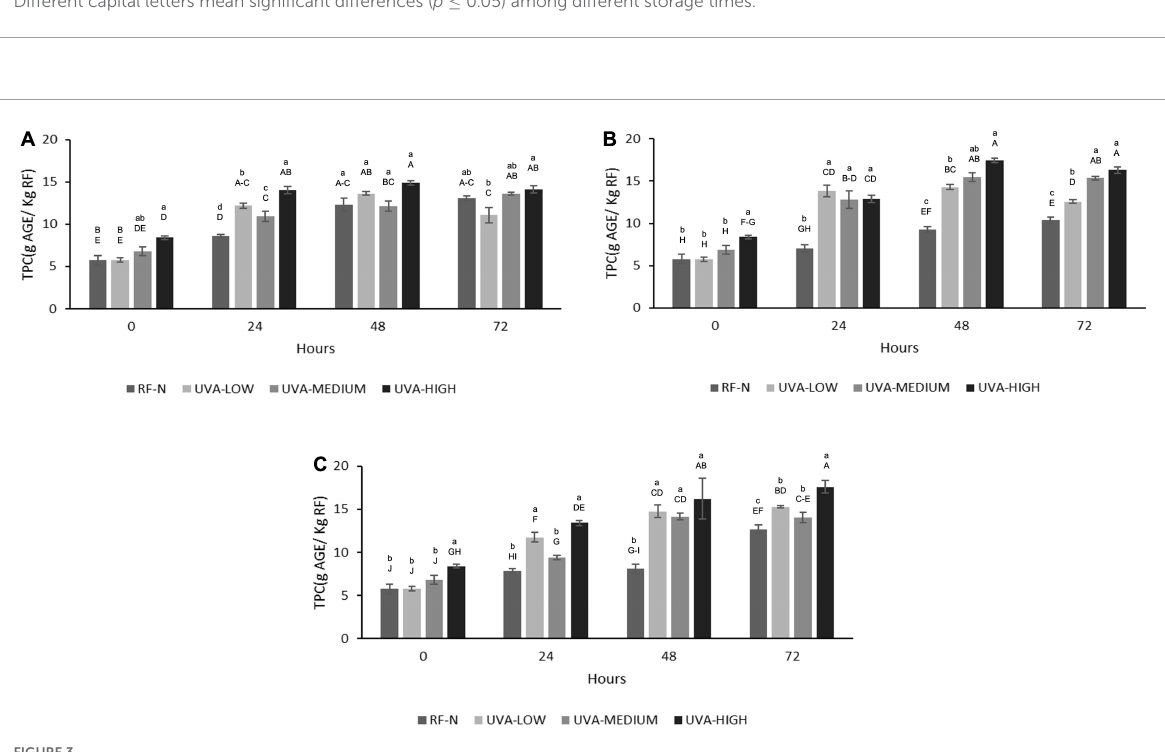
FIGURE3 Total phenolic content (TPC) of UVA-treated strawberry by-products during storage at (A) 5 ◦ C, (B) 10 ◦ C, (C) 15 ◦ C. RF-N: Strawberry agro-industrial by-product control. UVA-LOW: RF irradiated with 28.8 KJ/m 2 . UVA-MEDIUM: RF irradiated with 57.6 KJ/m 2 . UVA-HIGH: RF irradiated with 86.4 KJ/m 2 . Different lower-case letter, means significant differences ( p ≤ 0.05) between the different treatments at the same storage time. Different capital letter means significant differences ( p ≤ 0.05) between different storage